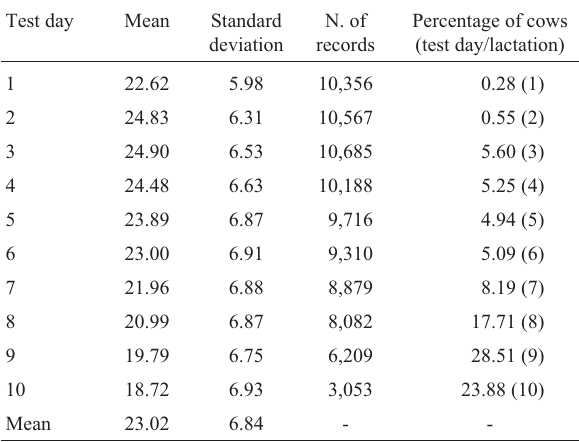
Table 3 - Means and standard deviations of milk yield, number of test-day records and percentage of cows with the respective number of test-day re - cords per lactation (given in parentheses).